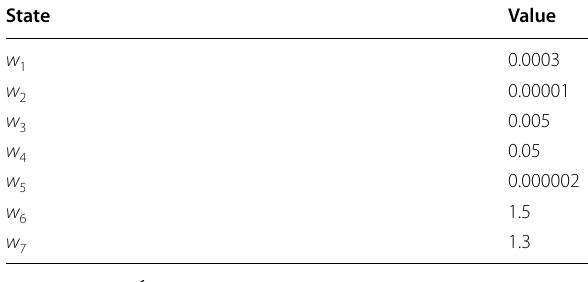
Table 4 Conditions for ACC simulations Table 5 Tuned weights for the reward function for RL